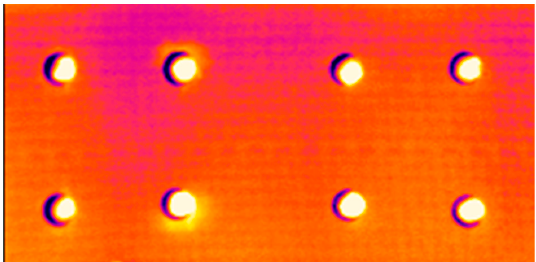
Figure 10. Delamination around holes in a drilled carbon epoxy part; phase image taken with Agema 900 camera.